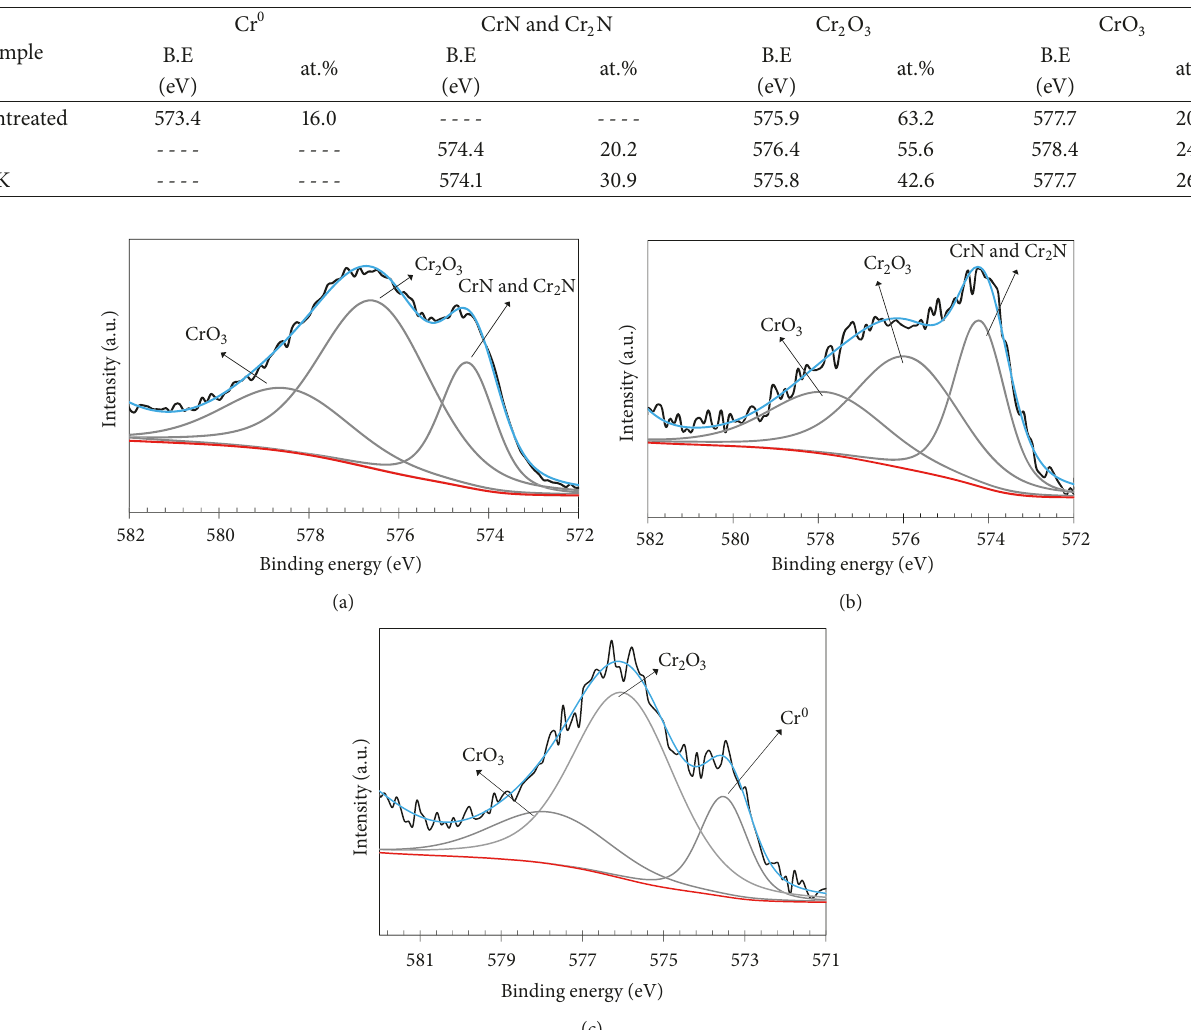
Table 2: XPS fitting results for the Cr2p 3/2 core level.